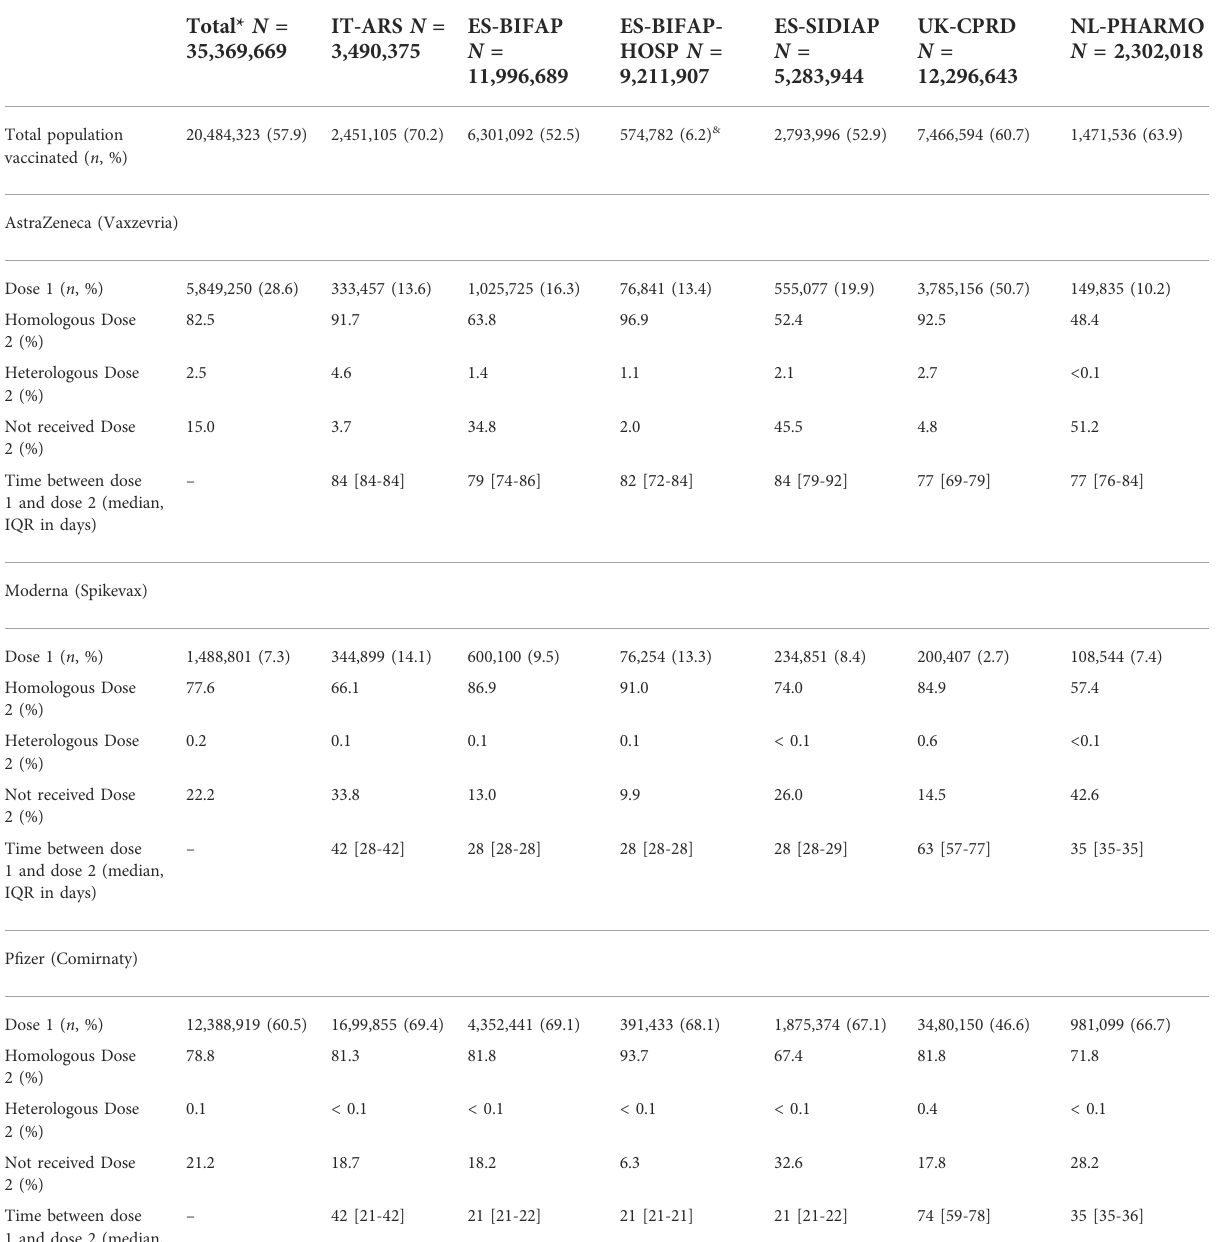
TABLE 3 Vaccinated persons and distances in days between dose one and for all COVID-19